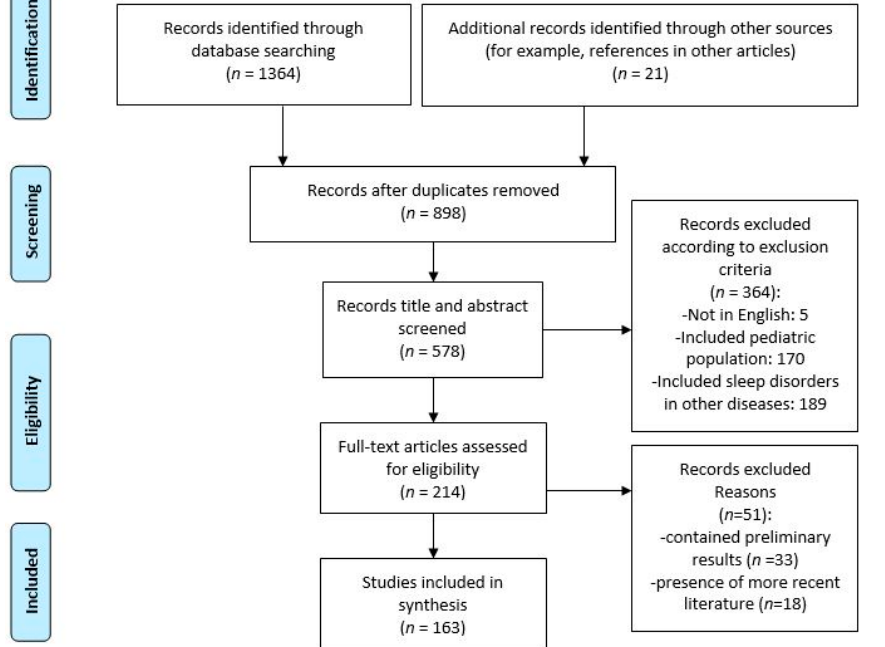
Figure 1. Flow chart used to perform the review.